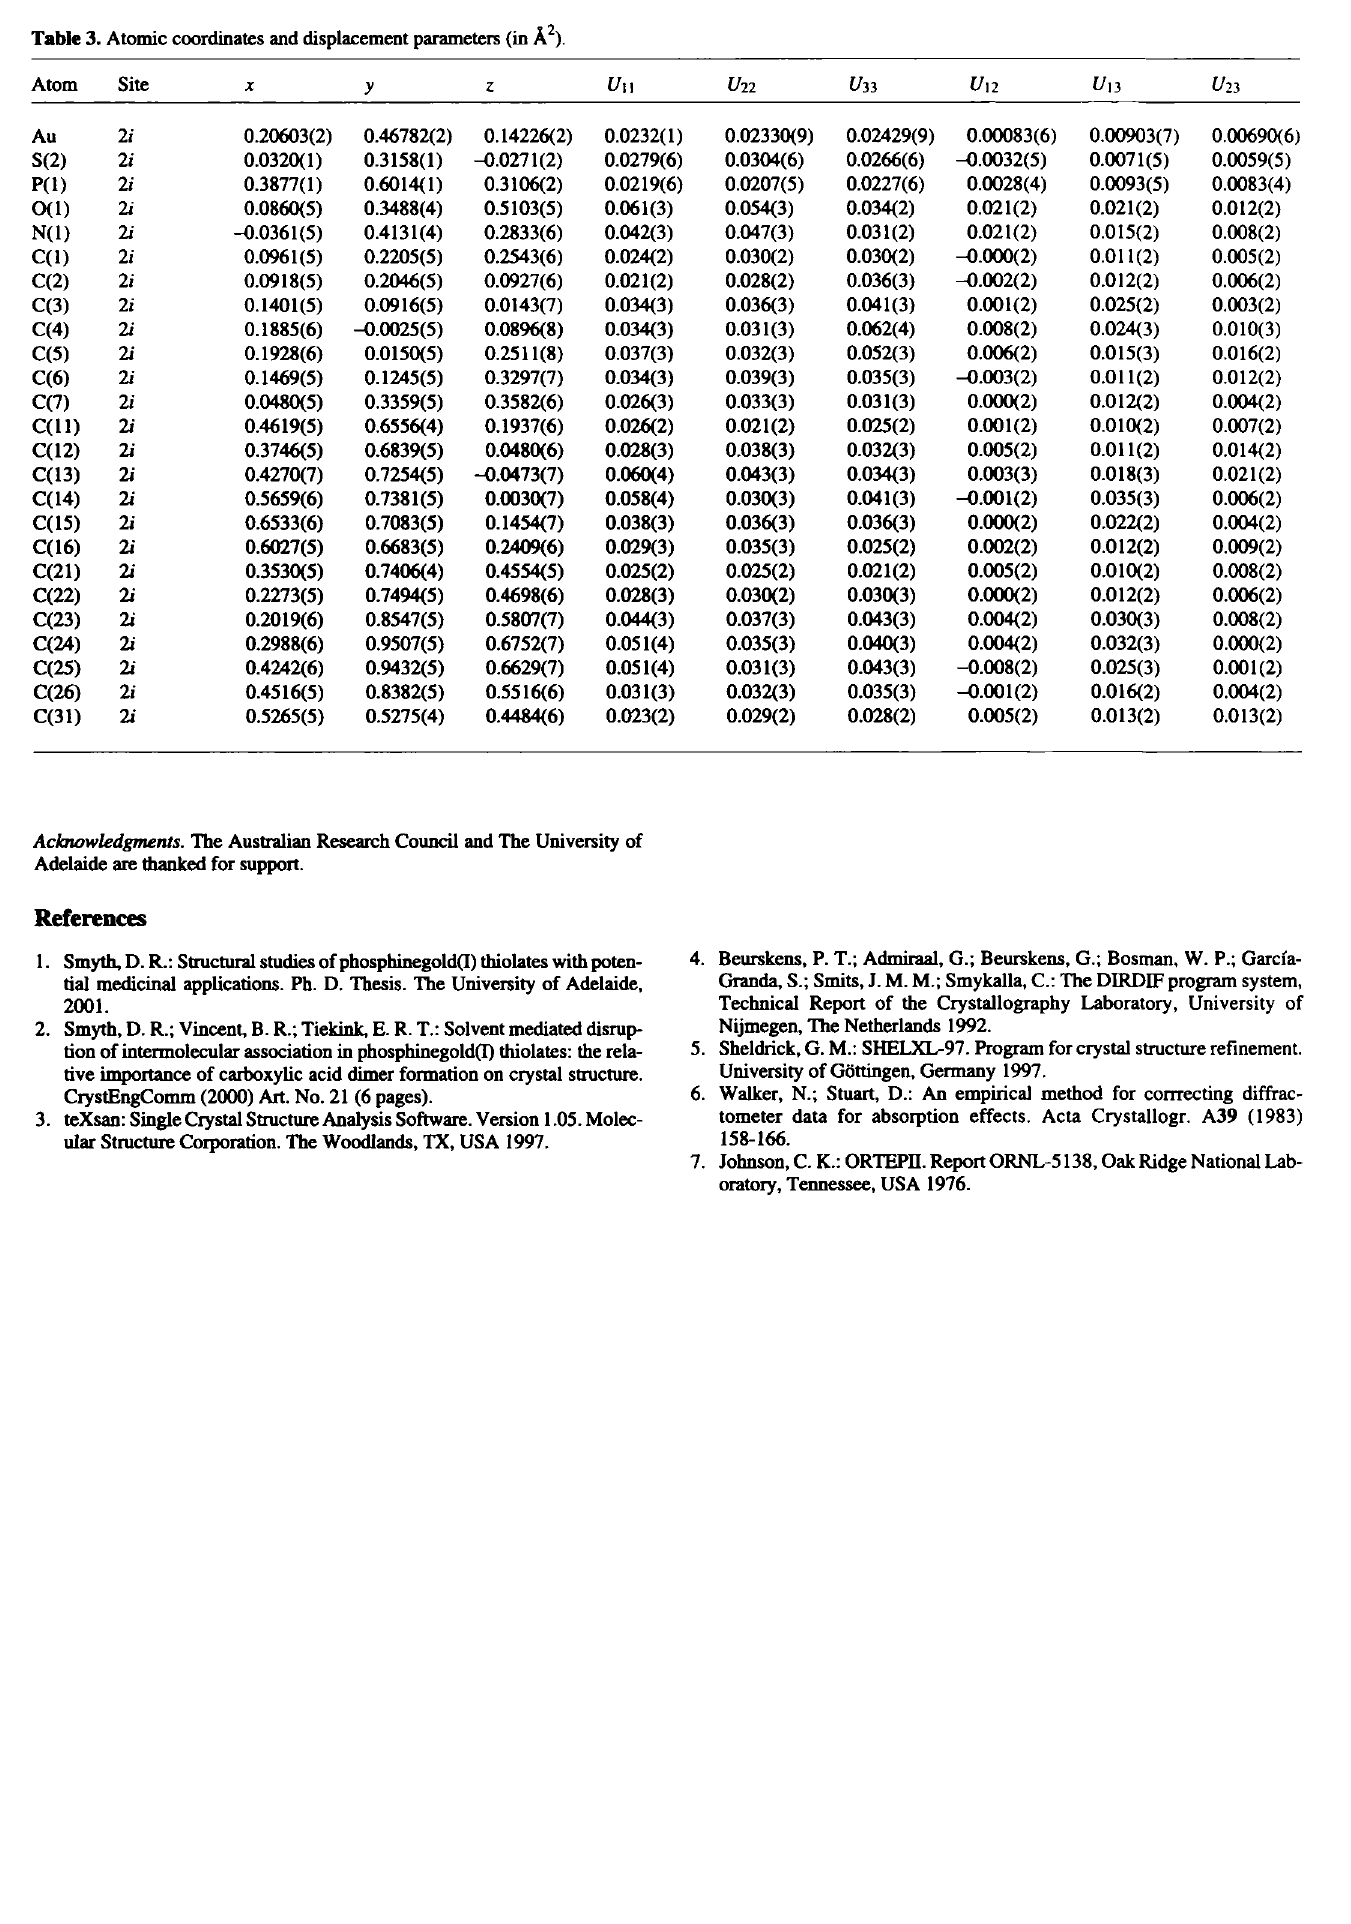
Table 3. Atomic coordinates and displacement parameters (in Â 2